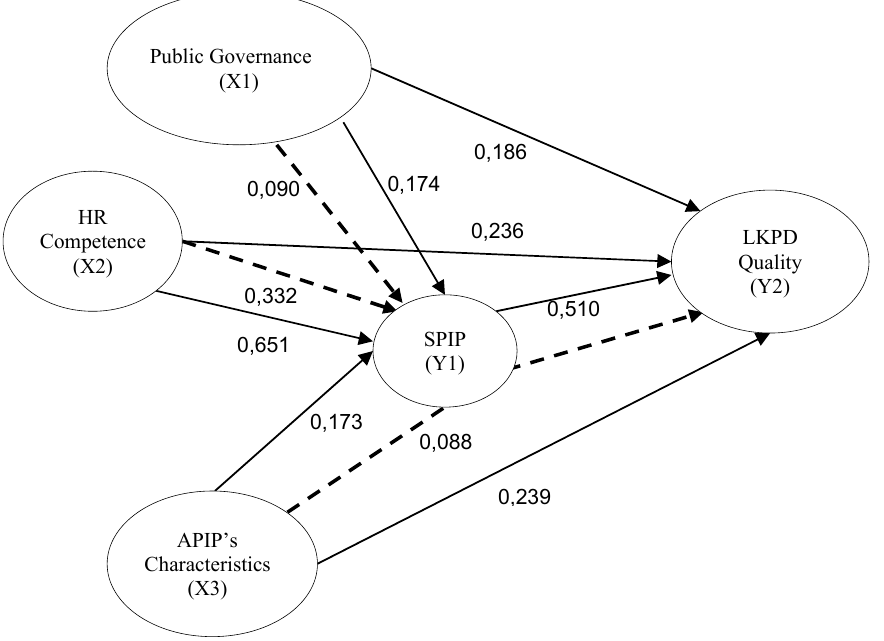
Fig. 2. The Analysis Results of Direct Influence with SPIP as the Mediator